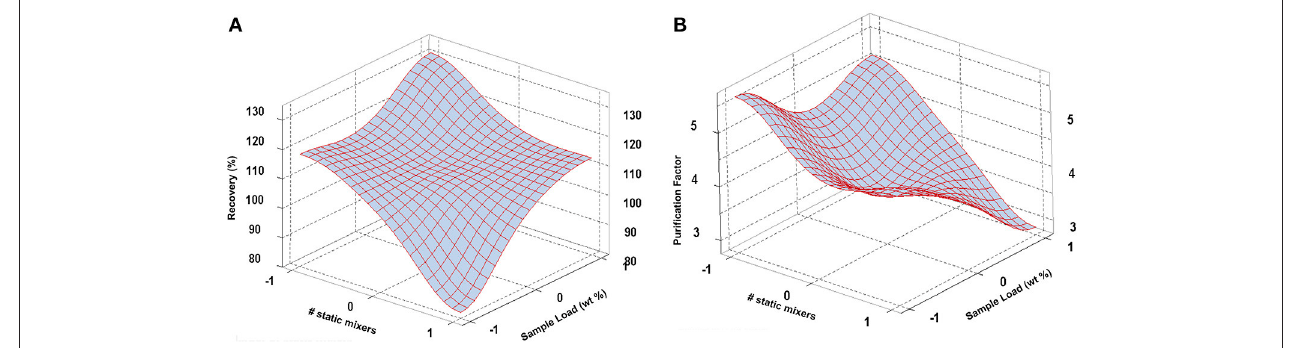
FIGURE 3 | Response surface plots for recovery yield (A) and purification factor (B) of invertase from spent brewer’s yeast considering the effect of sample load (X3) and number of static mixers (X4).